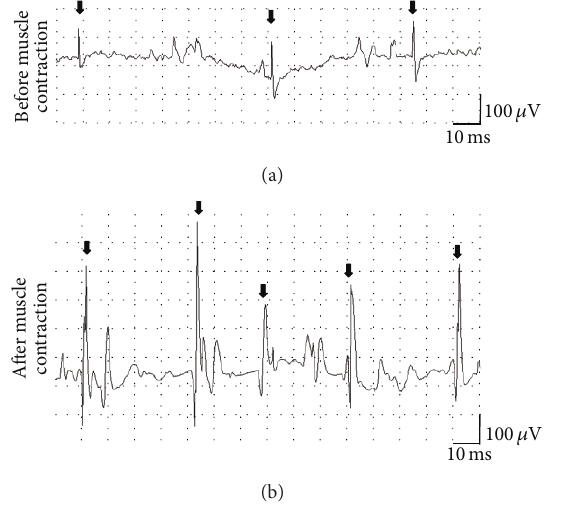
Figure 1: Needle EMG findings in patient 1. The MUPs (arrows) withshortdurationsandlowamplitudeswereobservedinthebiceps brachii muscle (a). After a strong muscle contraction for 10s, the MUP sizes were normalized